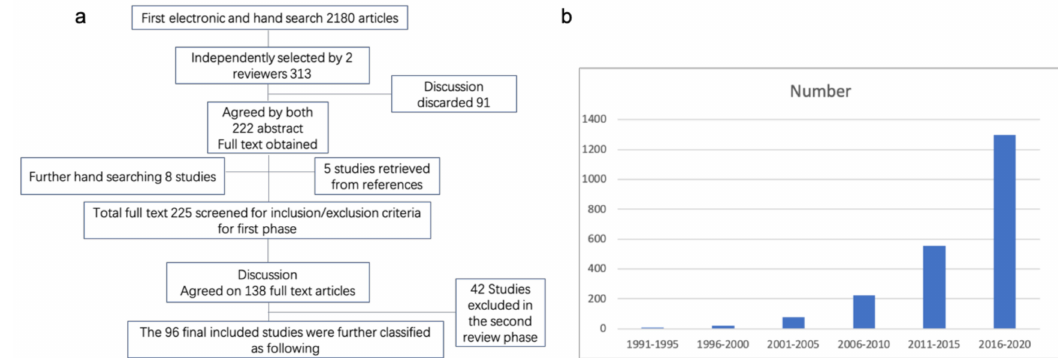
Figure 1. ( a ) Search strategy used to identify the included studies. ( b ) Graph representing the publication of hydrogel applicability shown with